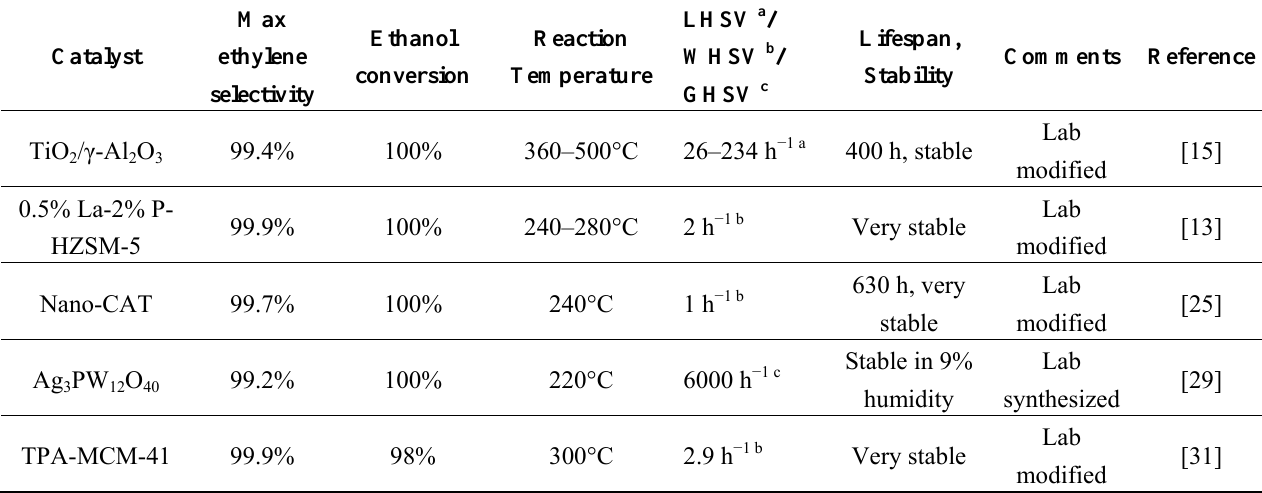
Table 2. Summary of catalysts for the dehydration of ethanol to ethylene and their catalytic ability.